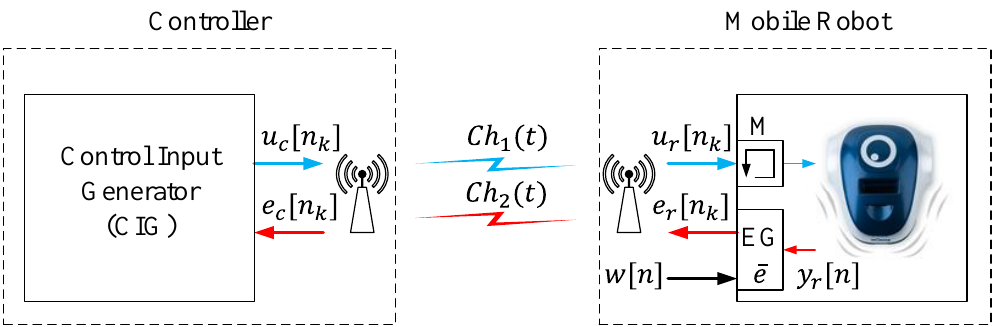
Figure 3. Proposed event-based control